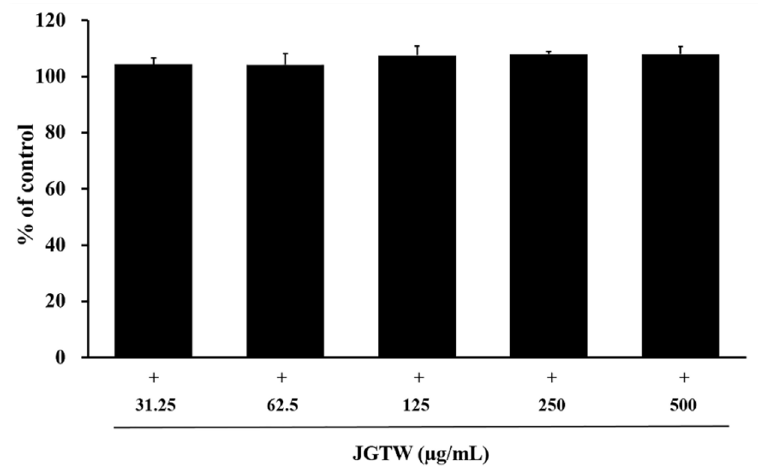
Figure 2. Cytotoxicity effect of JGTW in BEAS-2B cells. Cell viability after 24 h JGTW treatment was assessed and the values are presented as mean ± SEM.